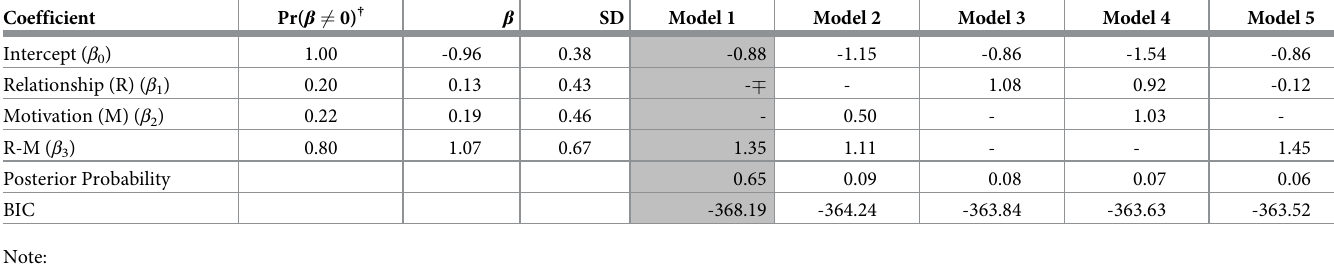
Table 10. Summary statistics from the Bayesian Model Averaging analysis �